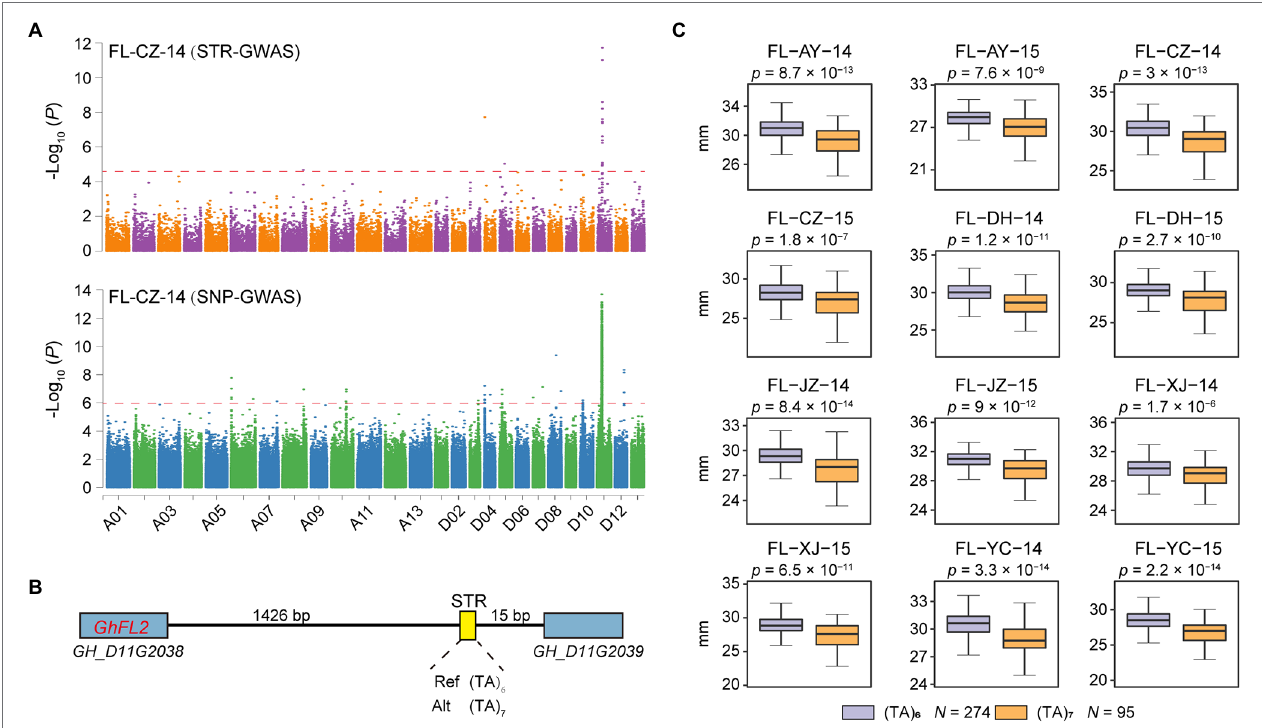
FIGURE 4 | The STR D11:23844508 associated with fiber length. (A) Combined Manhattan plot for FL based on STRs (top) and SNPs (bottom) in P3. (B) The LocusZoom plot (D11 from 23.843 to 23.845 Mb). (C) Box plot for FL according to the two haplotypes of STR D11:23844508 in P3 ( n = 274 vs. 95). Center line, median; box limits, upper and lower quartiles; and whiskers, 1.5× the interquartile range (* p < 0.05, two-sided t -test). AY: Anyang in Henan Province; CZ: Cangzhou in Hebei Province; DH: Dunhuang in Gansu Province; JZ: Jingzhou in Hubei Province; XJ: Alaer in the Xinjiang; and YC: Yancheng in Jiangsu Province. 14: 2014; 15: